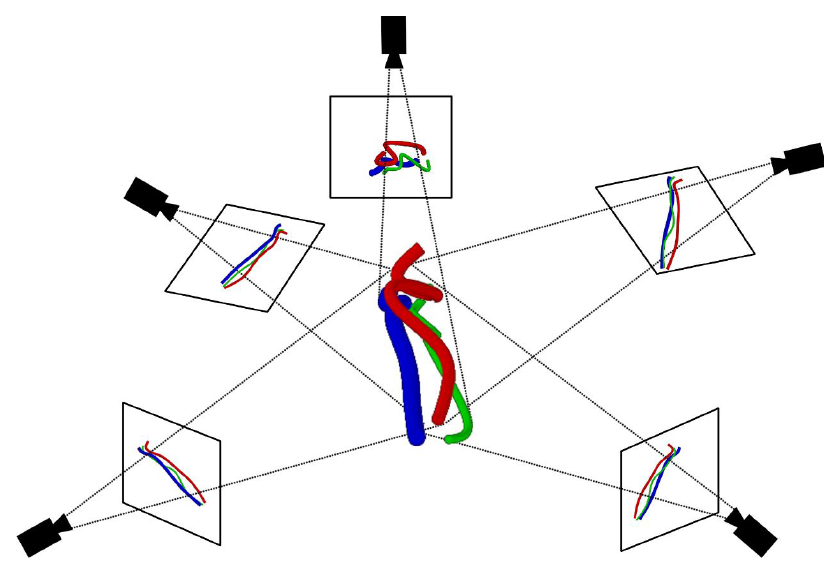
Sensors 2021 , 21 , x FOR PEER REVIEW Figure 2. Complex tube system acquired by different camera locations. Figure 2. Complex tube system acquired by different camera locations.